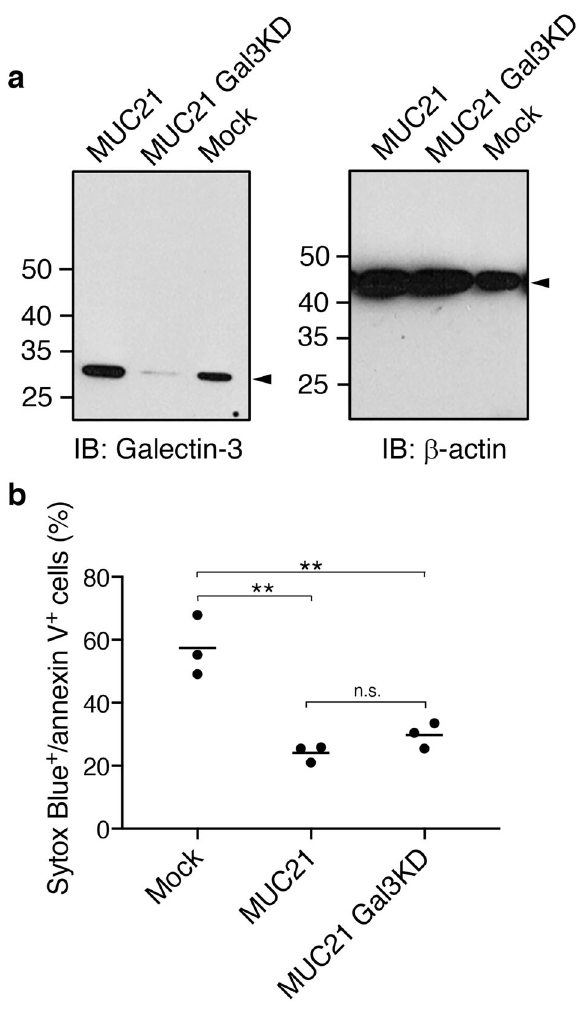
Fig. 7 Galectin-3 silencing by shRNA does not alter the MUC21- dependent apoptosis resistance in HEK293 cells. a To con fi rm the knockdown of galectin-3 by shRNA, equal amounts of protein from cell lysates of mock transfectants (Mock), full-length MUC21 transfectants (MUC21,) and galectin-3-silenced full-length MUC21 transfectants (MUC21 Gal3KD) were separated by SDS-PAGE, blotted onto nitrocellulose membranes, and probed with anti-galectin-3 mAb TIB166 (left panel) or anti- β -actin mAb AC-74 (right panel). The arrowheads indicate the position of galectin-3 (left panel) and β -actin (right panel). b Mock cells, MUC21 transfectants, and MUC21Gal3KD transfectants were treated with 100 μ M etoposide for 24 h. Cells were stained with Sytox Blue and annexin V, and the percentage of apoptotic cells was analyzed. Three independent experiments are shown. The mean is indicated as a horizontal line. One-way ANOVA with Tukey ’ s multiple-comparison test. ** p < 0.01, n.s. not signi fi